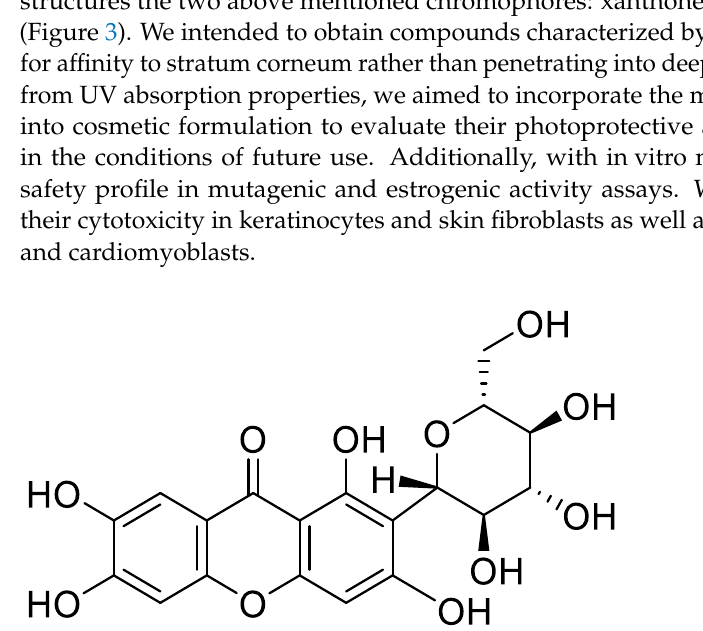
Figure 1. The chemical structures of octinoxate (INCI: Ethylhexyl methoxycinnamate) ( a ) and octocrylene ( b ).